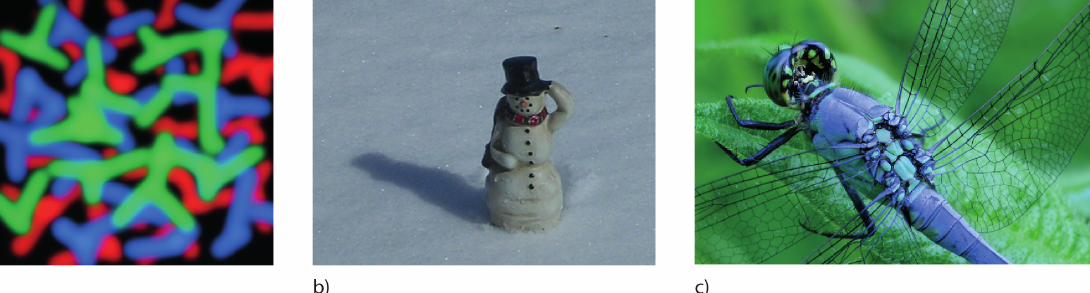
Figure 1. Images of different scoring ranges belonging to the dataset used in this work, evaluated by humans according to their quality. ( a ) Image with an average score of 2.7 out of a maximum of 10. ( b ) Image with an average score of 5.7 out of a maximum of 10. ( c ) Image with an average score of 9.28 out of a maximum of